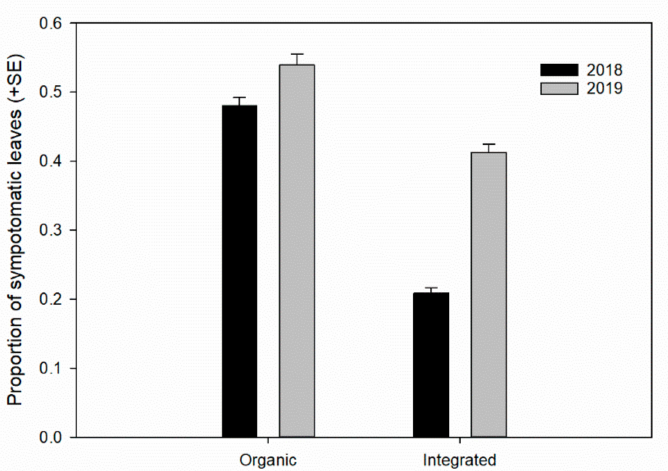
Figure 5. Proportion of leaves with symptoms of Liothrips oleae attack (see Figure 1b) with di ff erent types of phytosanitary